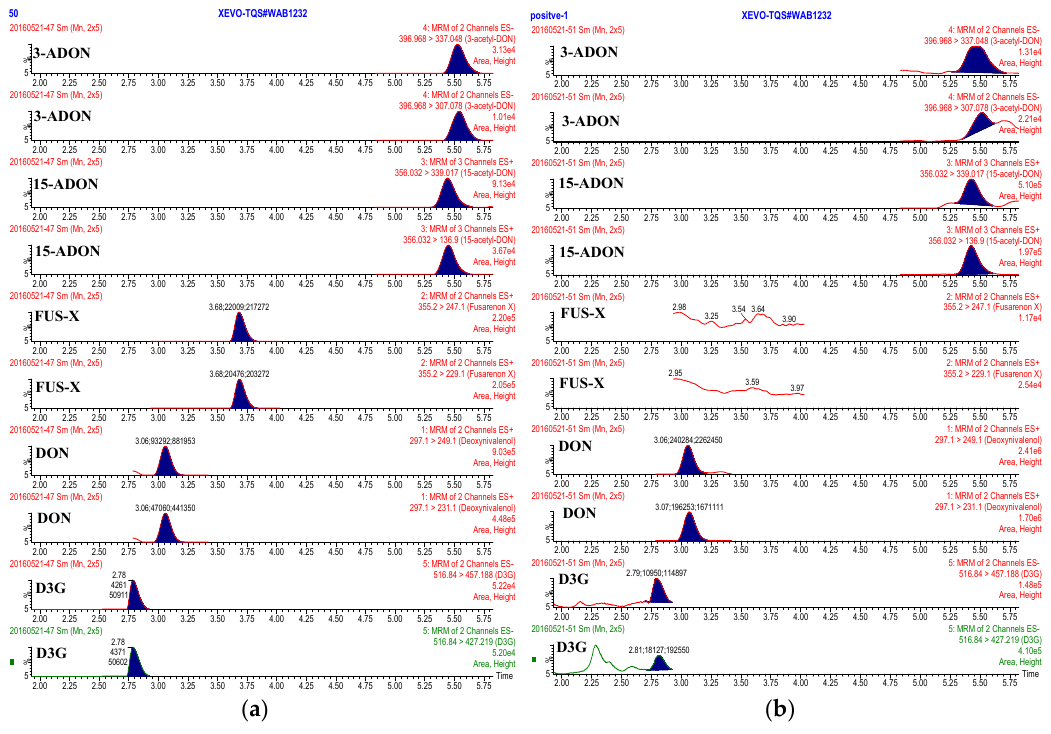
Figure 4. MRM chromatograms of five targeted mycotoxins in the standard solutions ( a ) and in a contaminated concentrated feed sample ( b ). The concentration of the mycotoxins in ( a ) is 50 μ g/kg. Table 3. Occurrence of D3G and four major type B trichothecenes in formula feed, concentrated feed, and premixed feed samples.